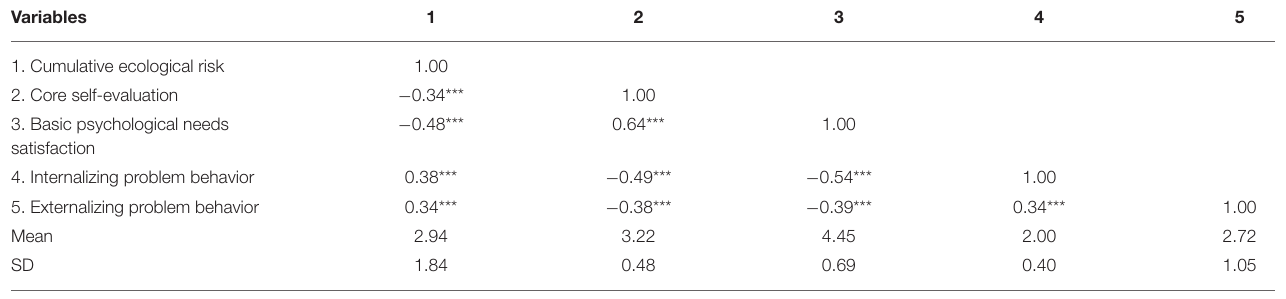
TABLE 1 | Correlation matrix for all variables.